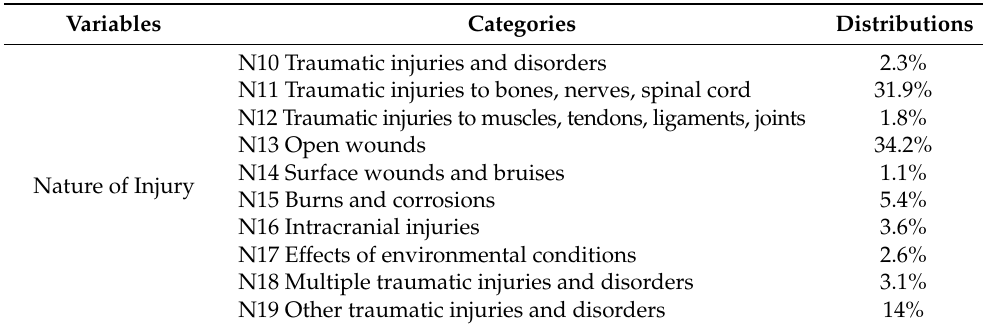
Table 2. Categorical variables and data